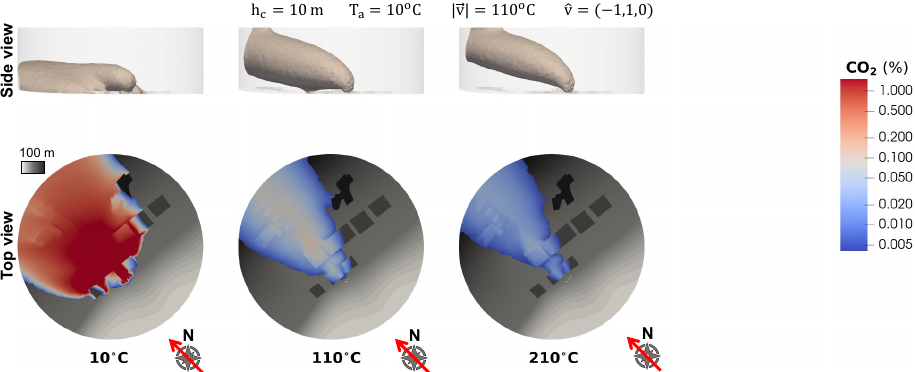
Figure 6. Exhaust gas Temperature. Concentration of CO 2 at ground level for wind speed u = 5 m/s and north-west ( − 1,1,0 ) direction. The chimney height is 10 m and the ambient temperature 10 ◦ C in all cases. The terrain height is represented in a grayscale. Lighter colors correspond to lower heights and the sea has the lightest color. The chimneys are three white spots near the coastline. The upper panels, show the concentration of CO 2 within the plume. The 0.1%, 1000 ppm, surface for CO 2 was plotted in all cases.